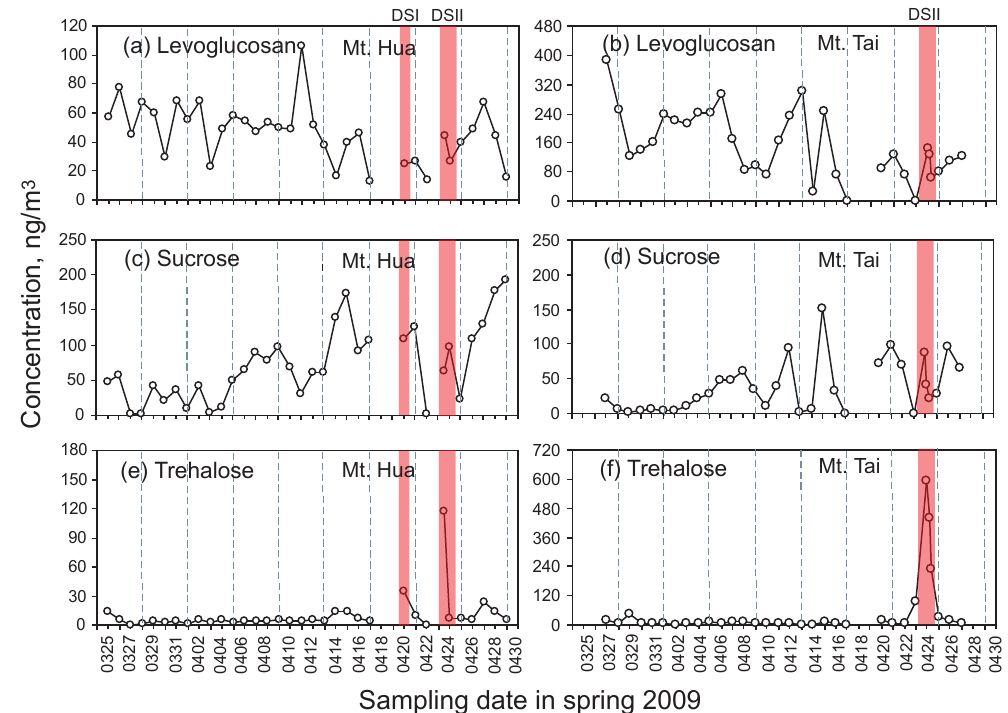
Fig. 6. Temporal variations of sugars in the PM 10 samples at Mt. Hua and Mt. Tai during the spring of